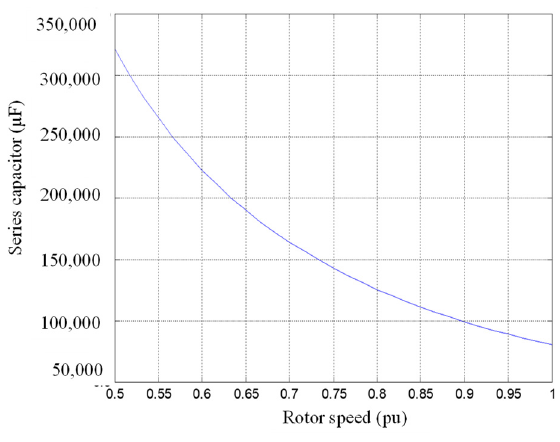
Figure 9. C s variation.